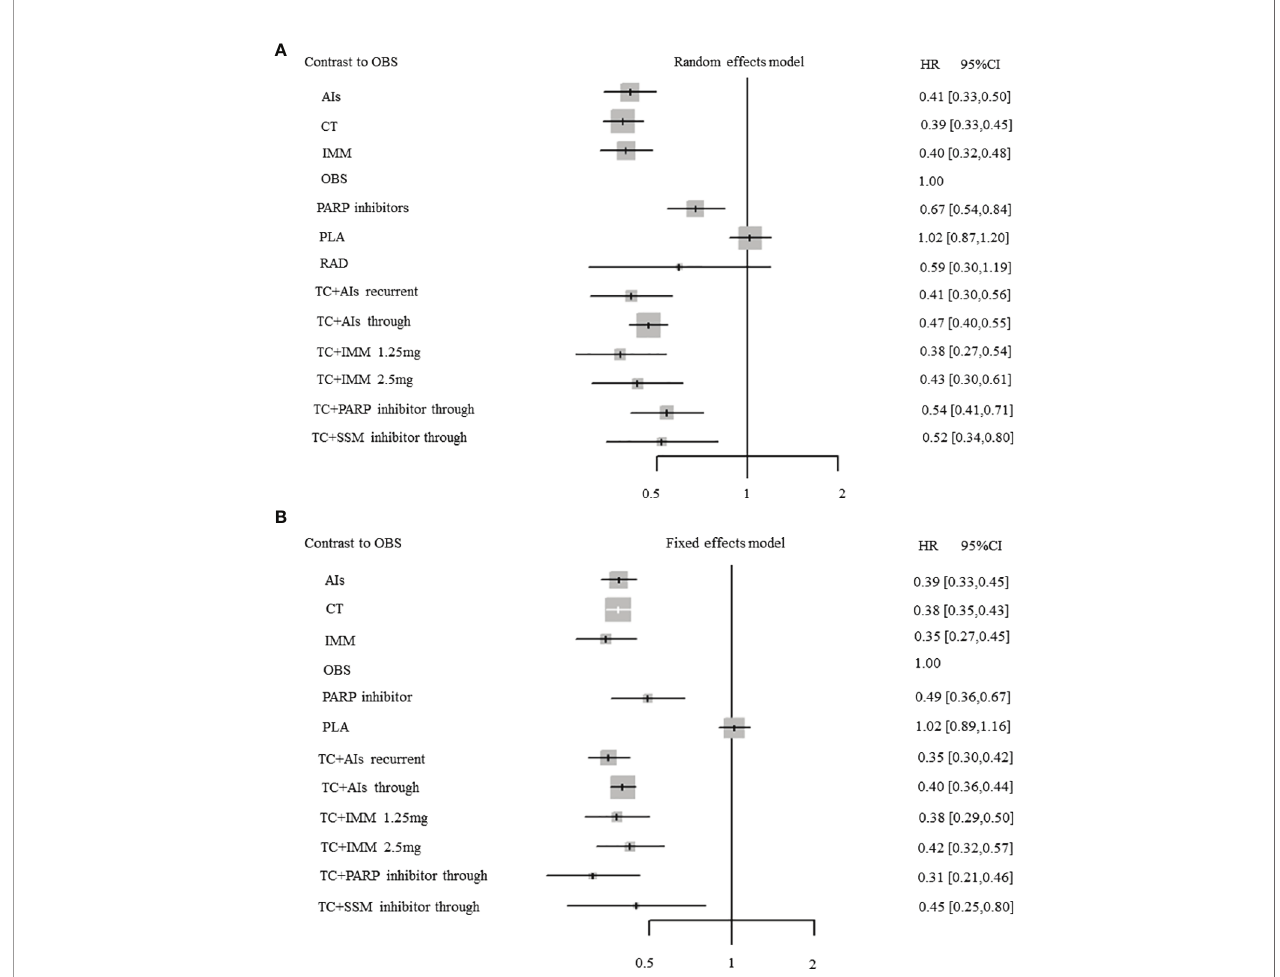
FIGURE 4 | Forest plots. (A) Progression-free survival (PFS). (B) Overall survival. Hazard ratios and 95% con fi dence intervals (95% CIs) of each treatment versus observation in the maintenance therapy of ovarian cancer. Central dots represent medians; lines represent 95%